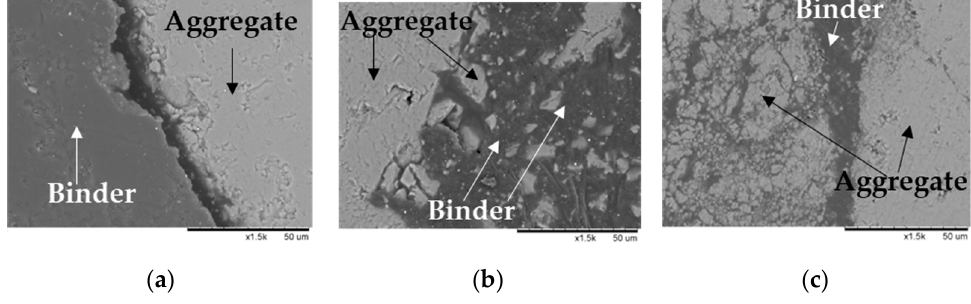
Figure 13. SEM characterization at 1500× magnification: ( a ) HMA, ( b ) HMAJ, and ( c )